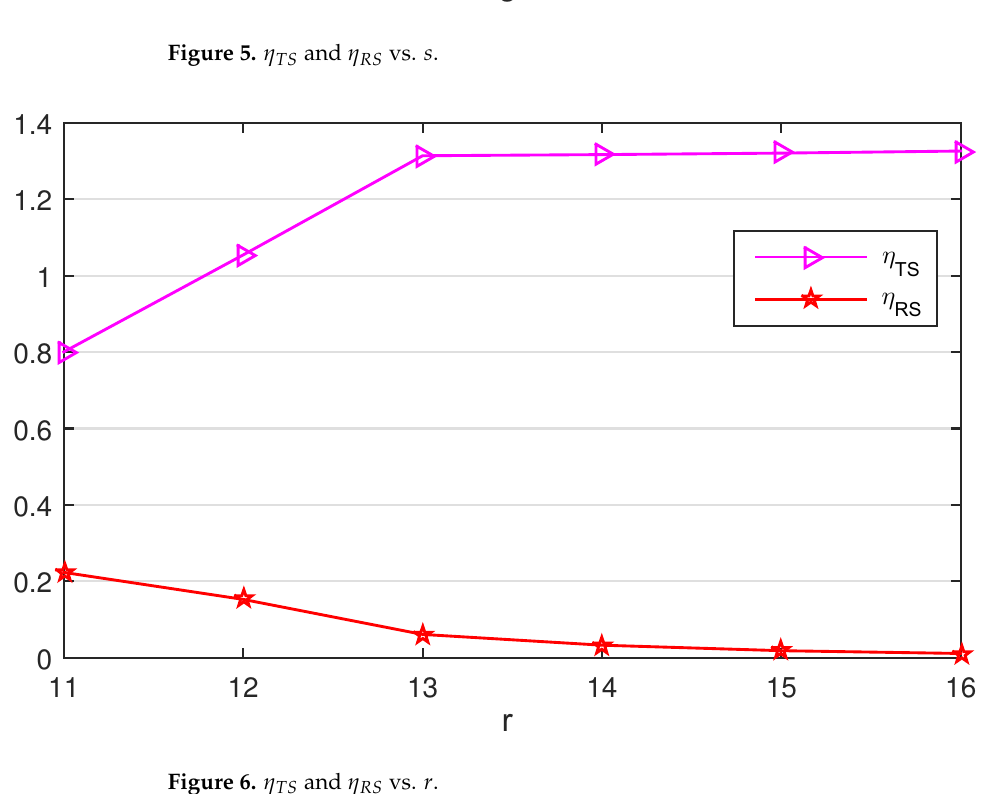
Figure 5. η TS and η RS vs. s .